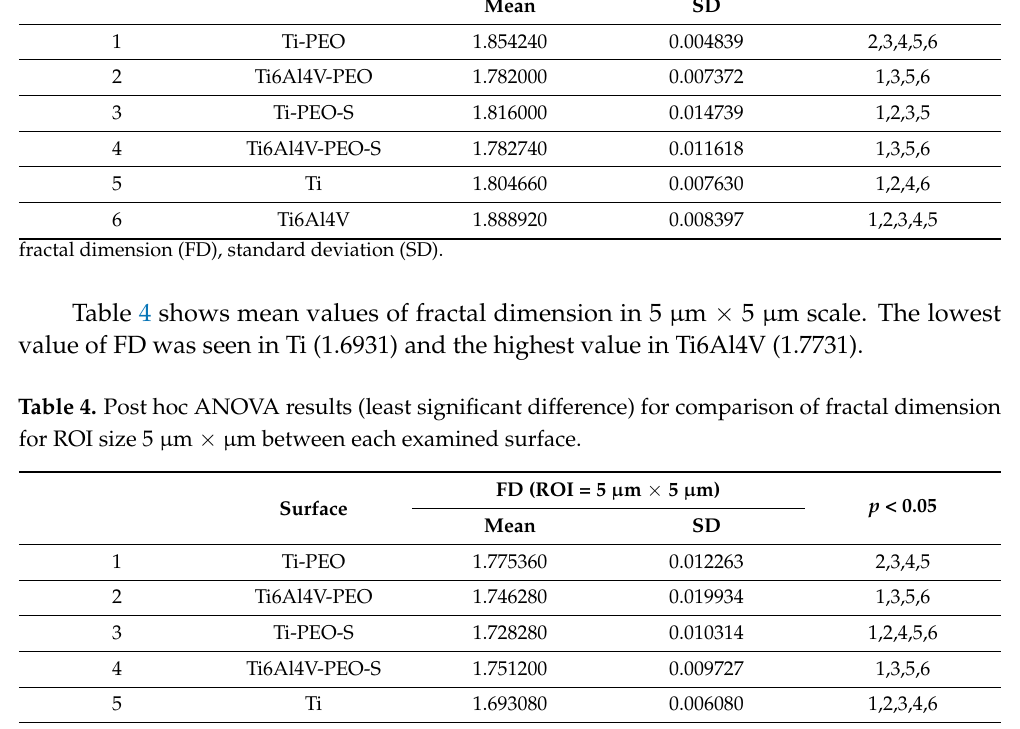
Table 5. The values of the Pearson correlation coefficient between the value of fractal dimension calculated in different scale (100 µ m × 100 µ m and 5 µ m × 5 µ m) and the Sa and number of cells per mm 2 and medium Au and differential entropy. Feature Versus (vs.)